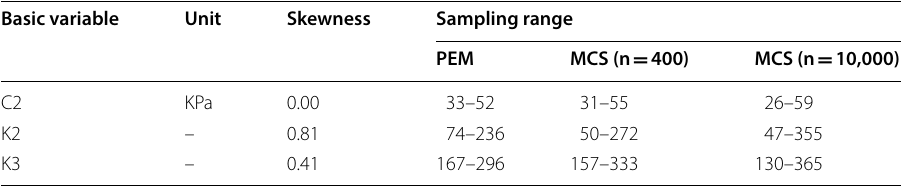
Table 7 Sampling range of uncertain variables in PEM and MCS Basic